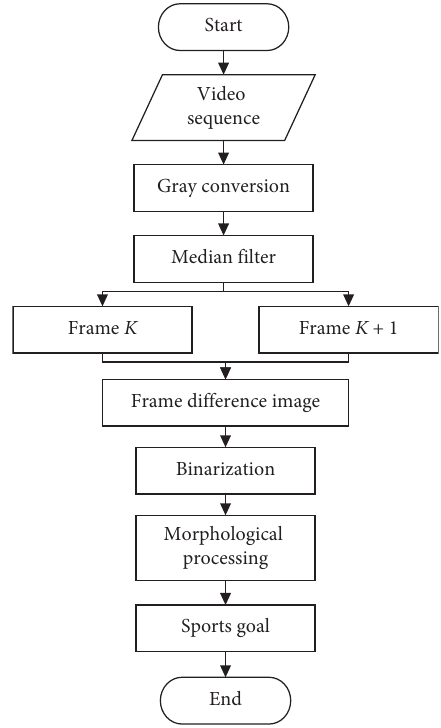
Figure 1: Interframe difference method